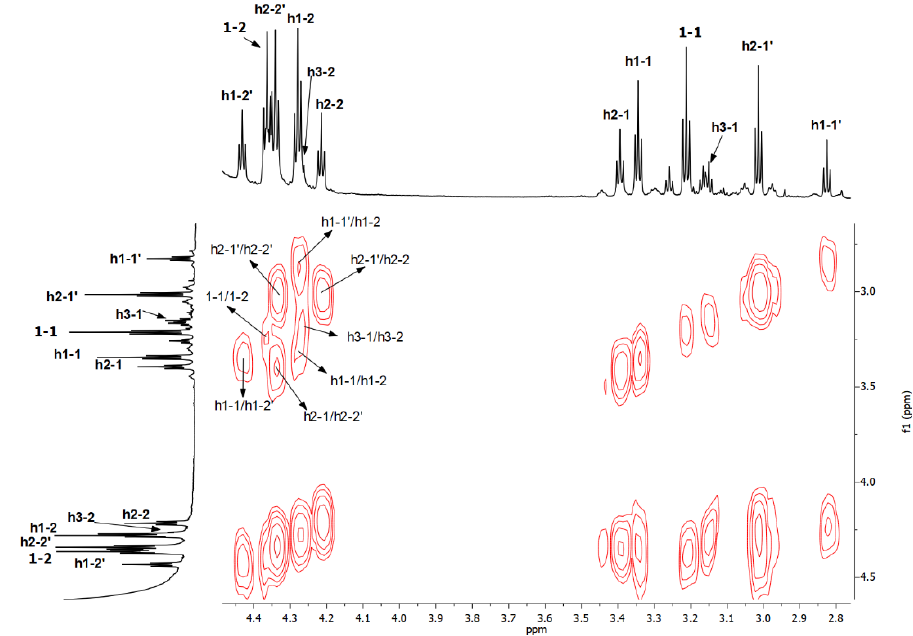
Figure 5. 1 H- 1 H COSY NMR spectrum of 1 , immediately after adding NaOD (pD = 7.8).